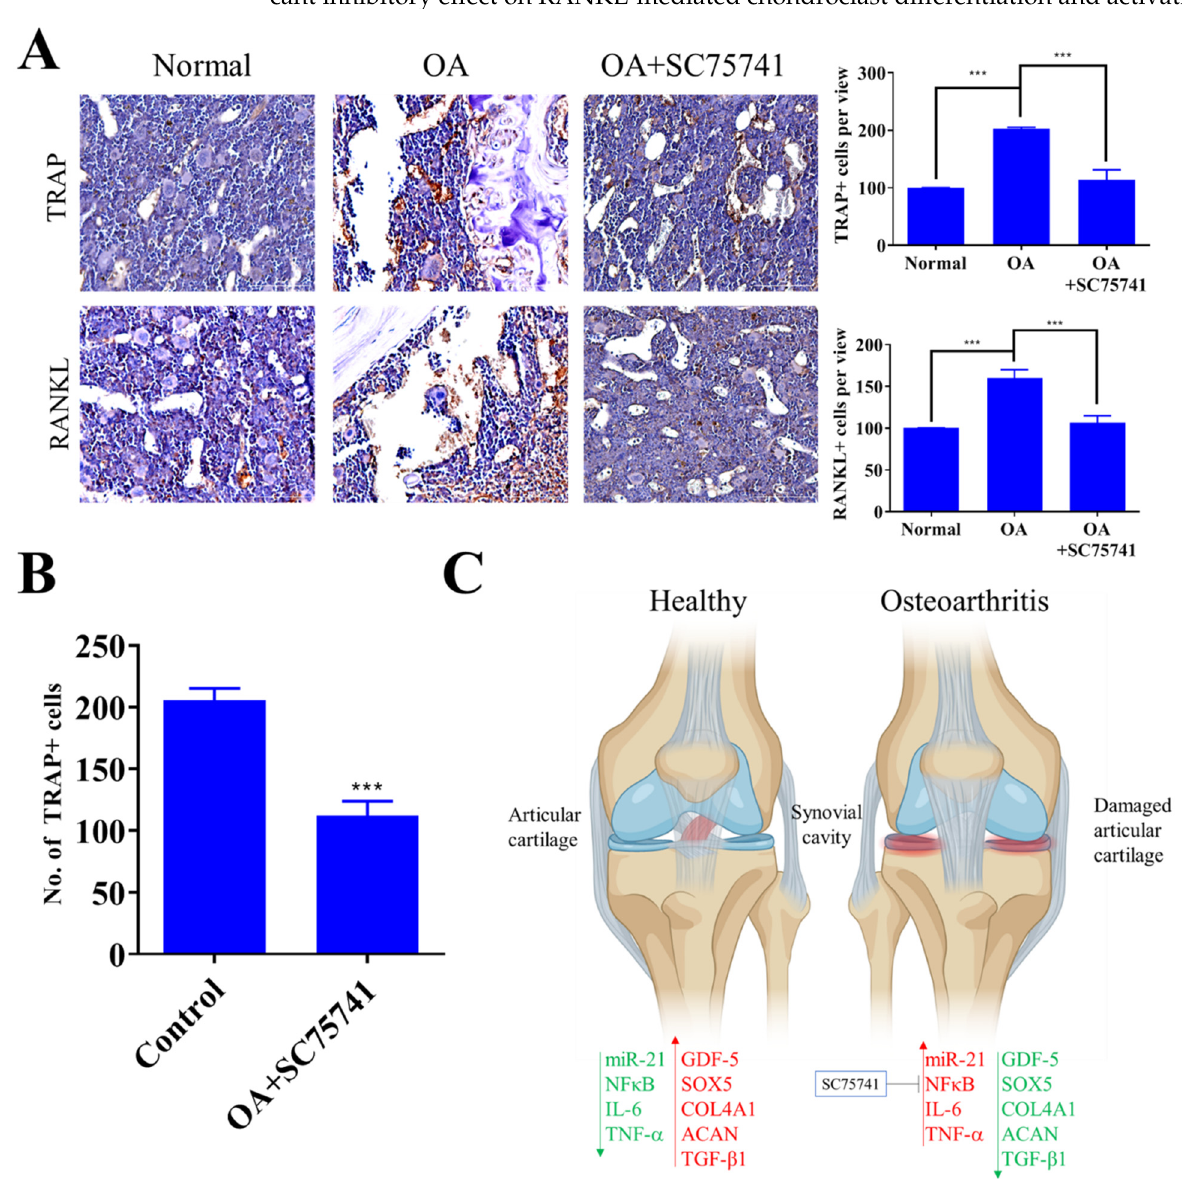
Figure 6. The effect of SC75741 on histopathology analysis showed a reduction of osteoclast formation and activity after SC75741 treatment in the rat OA model. ( A ) IHC staining was analyzed to evaluate the level of osteoclast in bone and cartilage. ( B ) The monocytes isolated from the joints of OA mice and control mice were cultured with 10ng/mL M-CSF and 2 μ M SC75741 or 50 ng/mL RANKL. After two weeks of culture, the TRAP+ multinucleated cells were counted (at 10X magnification). ( C ) Schematic representation demonstrated SC75741-induced inhibition of the NF κ B circuit suppressed miR-21 signaling in the activated chondrocytes while conversely upregulating its targets SOX5, TGF- β 1, GDF-5, and COL4A1, thus consequently impeding further articular chondrocyte destruction and facilitating the amelioration of OA. *** p < 0.001.